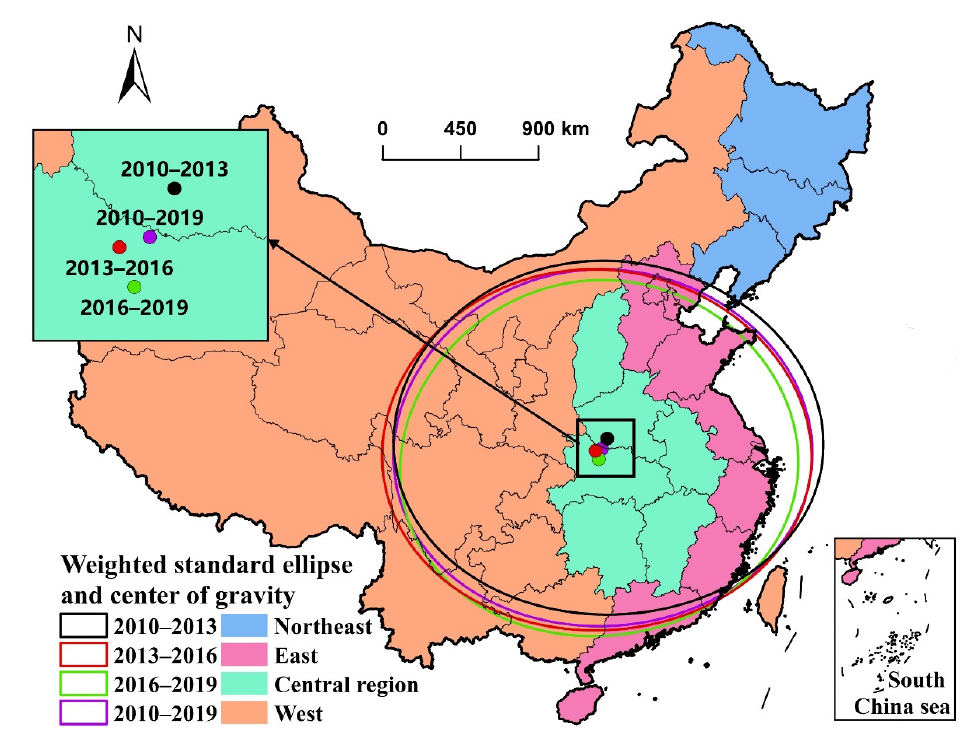
Figure 6. Weighted standard deviation ellipse of the industrial sprawl in China, 2010–2019 (The four colored dots express the gravity center of newly added industrial land area, and the four colored ellipses are the weighted standard deviation ellipses of 2010–2013, 2013–2016, 2016–2019, and 2010– 2019). Table 3. Parameters of weighted standard deviation ellipse of industrial sprawl.